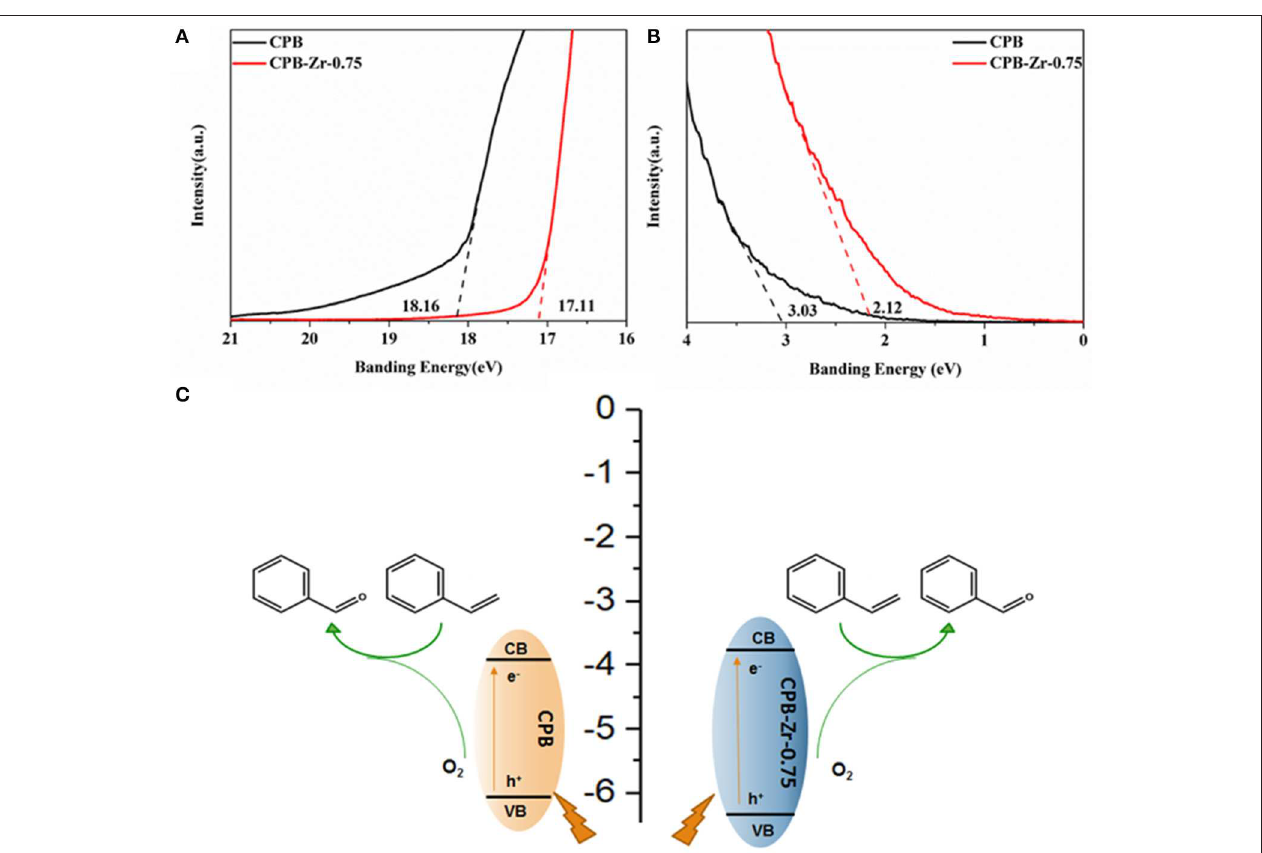
FIGURE 6 | The secondary electron cutoff edge (A) and Fermi edge (B) of CPB and CPB-Zr-0.75 in UPS spectra; schematic diagram of the reaction process for oxidation of the styrene into benzaldehyde (C) .